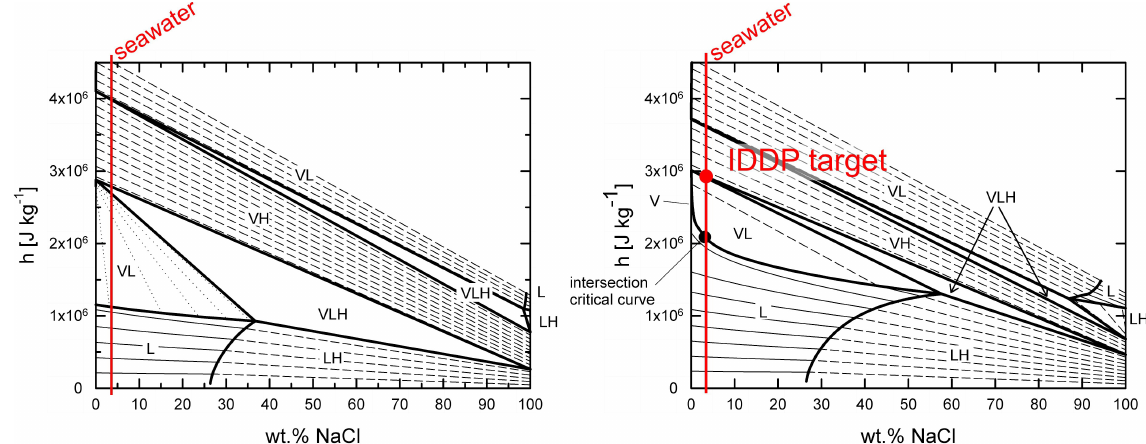
Figure 6. Enthalpy–salinity diagrams for geothermal conditions. Thin solid lines: isotherms in single-phase regions; dashed: isothermal tie lines in two phase regions. Based on Driesner